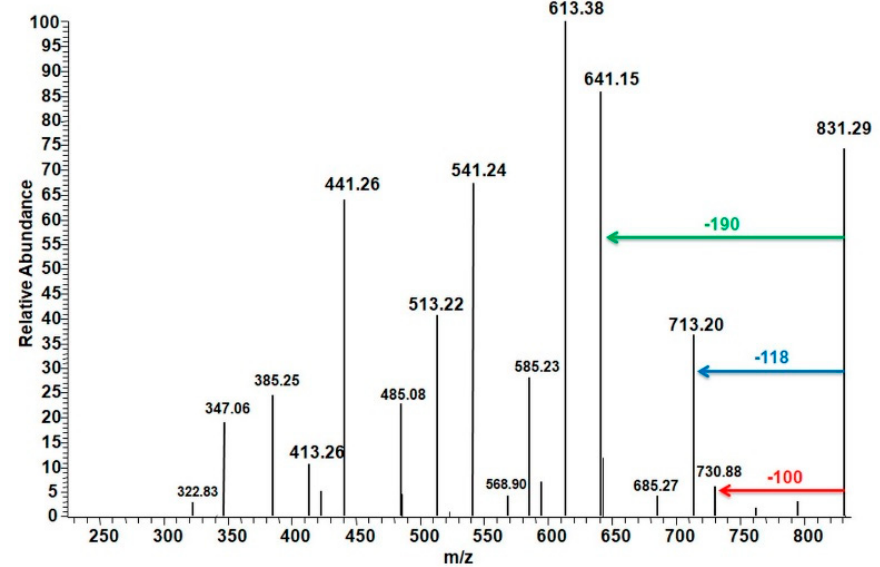
Figure 4. ESI ‐ MS/MS spectrum of the sodium adducts of poly( δ ‐ valerolactone) oligomers with benzyl Figure 4. ESI-MS/MS spectrum of the sodium adducts of poly( δ -valerolactone) oligomers with benzyl and carboxyl end groups at m/z 831 (Sample 1, Table 1). and carboxyl end groups at m/z 831 (Sample 1, Table